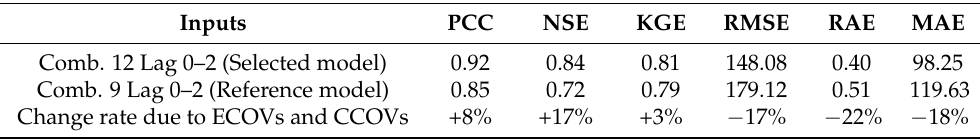
Figure 8. Karkheh observed vs. modelled monthly runoff time series ( a ) and q–q plots for calibration ( b ) and test ( c ) points (MCM: million cubic meters). Table 9. Performance criteria for the selected (Comb. 12 Lag 0–2) vs. reference model (Comb. 9 Lag 0–2) in testing points for Karkheh (RMSE and MAE are in million cubic meters while the others are unitless) and the change rate (%) between them.